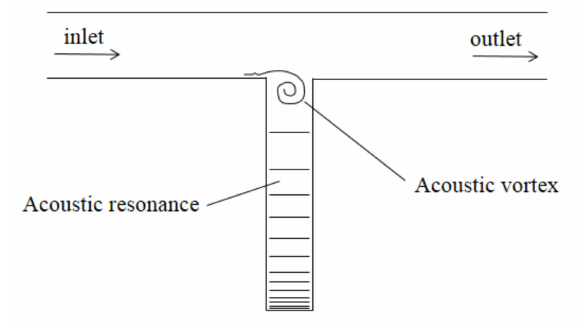
Figure 1. The gas flows through a closed side